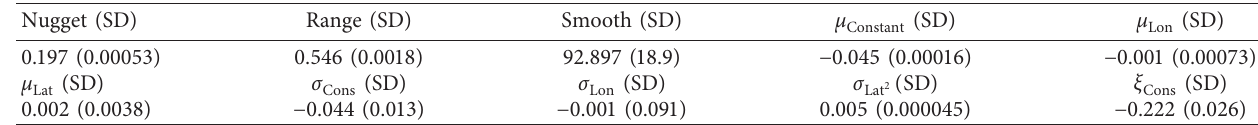
Table 5: Extremal t max-stable model parameter estimation using the location and scale with geographic coordinates (shape parameter considered constant).